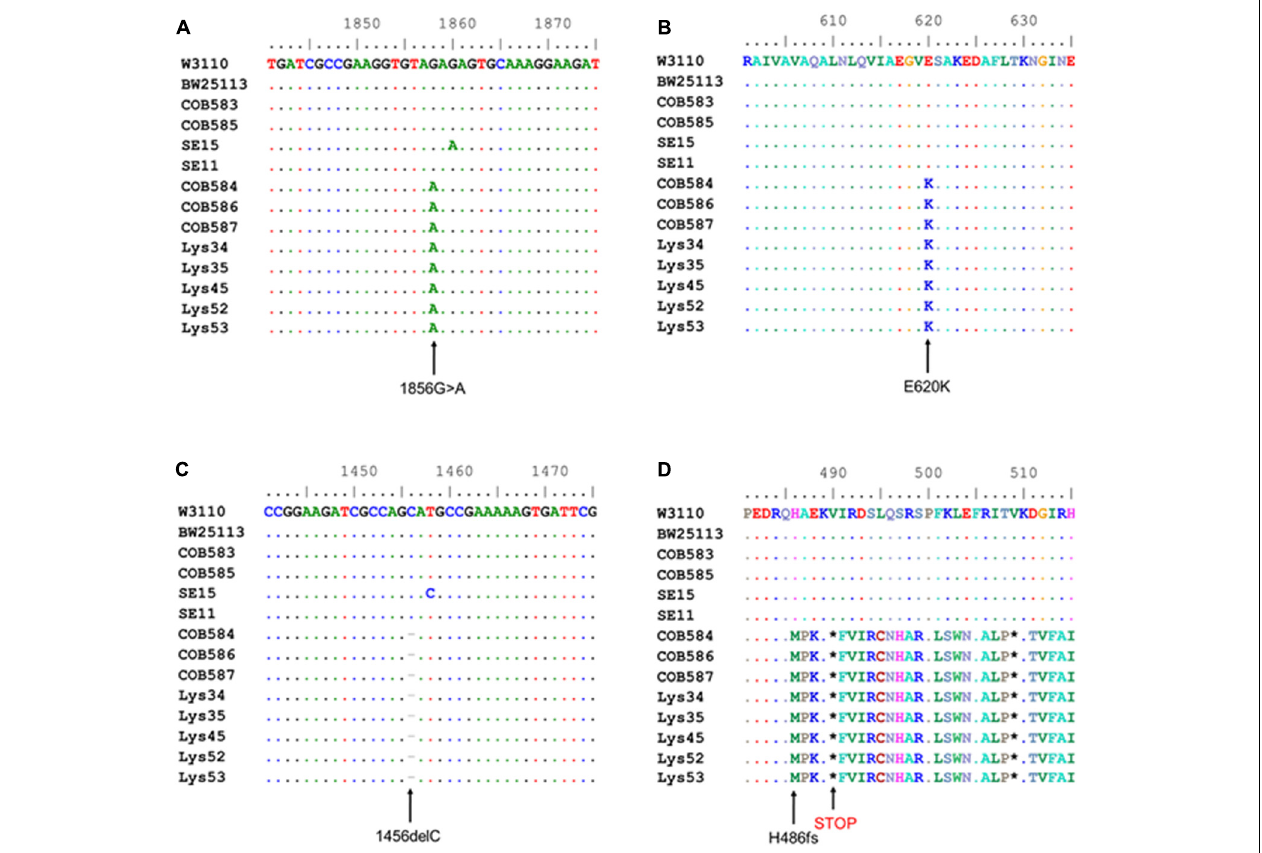
FIGURE 3 | Multiple sequence alignment shows mutations in cyclic-di-GMP metabolism genes in curli-negative soil-persistent Escherichia coli . Multiple sequence alignment of nucleotide sequences in cyclic di-GMP phosphodiesterase-encoding gene ( pdeR ) among 170 soil-persistent strains in our collection shows a point mutation (1858G > A) (A) which led to an amino acid change in the PdeR protein sequence (E620K) in COB584, COB586 and COB587 and five additional soil-persistent strains (B) . Alignment of the nucleotide sequence in diguanylate cyclase ( dgcE ) reveals a deletion (1456delC) (C) which results in a frameshift mutation at amino acid residue 486 in the protein sequence (H486fs) and a STOP codon at position 490 (D) . Multiple sequence alignment was performed using ClustalW in BioEdit v7.2.5).